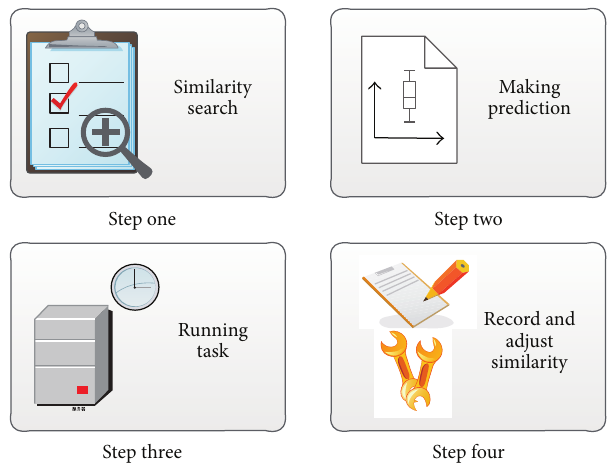
Figure 7: Our prediction has four steps. Upon a new task is in prediction, we firstly look for the most similar task in history and then make a prediction based on similar task. Then, we wait for the task running and record the running information and adjust weight setting scheme.